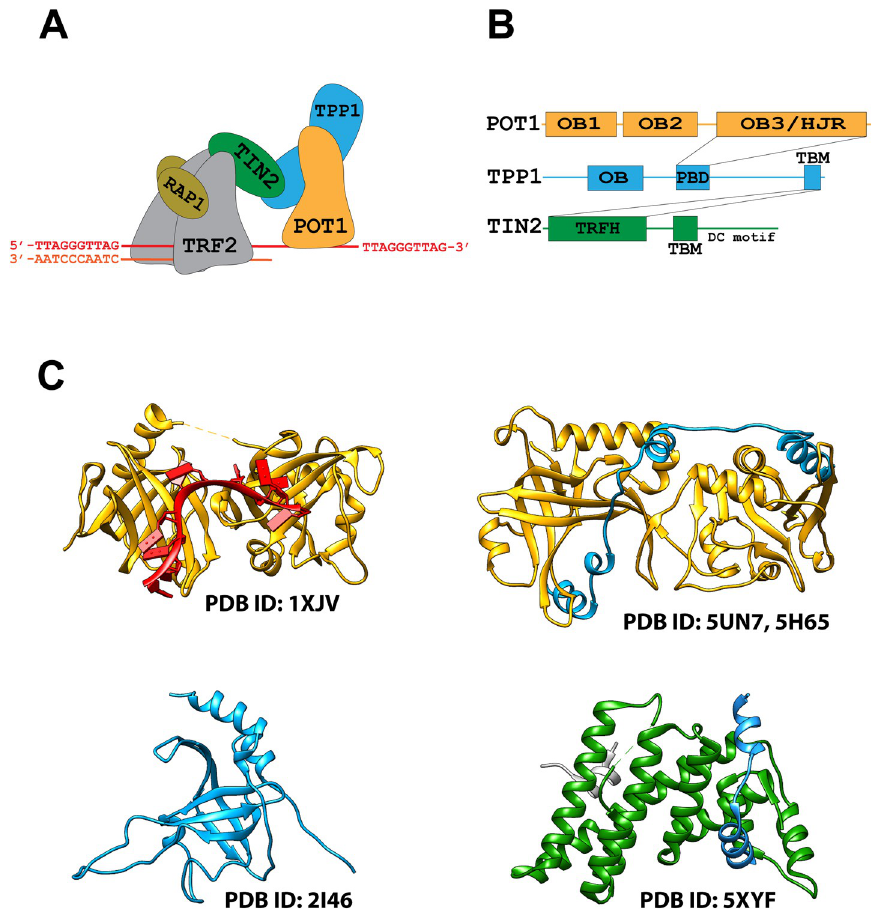
Fig 1. Composition and architecture of the shelterin complex. ( A ) Cartoon representation of the full shelterin complex POT1-TPP1-TIN2-TRF2(2 × )-RAP1(2 × ) bound to a telomeric double-stand/singe-stand junction. ( B ) Interaction map for the shelterin subcomplex POT1-TPP1-TIN2. The OB3/HJR domain of POT1 (orange) interacts with the PDB of TPP1 (blue), while the TBM of TPP1 (blue) interacts with TIN2 through the TRFH domain of TIN2 (green). TIN2 also has a TBM and a DC motif. ( C ) Published crystal structures of domains of the POT1-TPP1-TIN2 shelterin subcomplex: POT1 (OB1 & OB2) (yellow) bound to the minimal telomeric sequence TTAGGGTTAG (red) (PDB ID: 1XJV) (top left), POT1 (OB3 & HJRD) (yellow) bound by the PBD of TPP1 (E266-L326) (blue) (PDB ID: 5UN7, 5H65) (top right), TPP1 OB domain (blue) (PDB ID: 2I46) (bottom left), and TIN2(green)-TPP1(blue)-TRF2 (grey) interface complex (PDB ID: 5XYF) (bottom